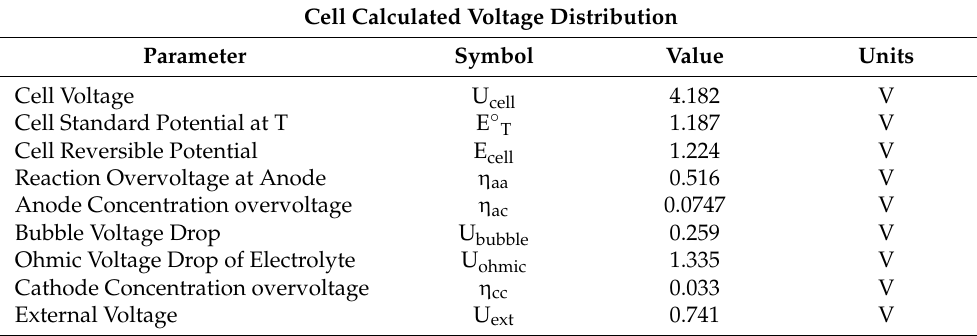
Table 2. Outputs of the Hall–Heroult Electrolysis Cell Energy Balance